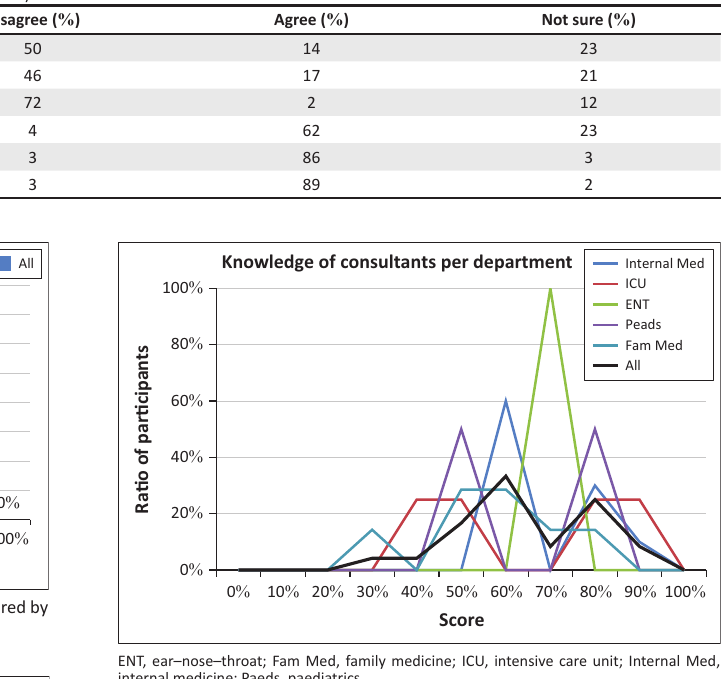
FIGURE 3: Comparison of consultants’ overall knowledge of ototoxicity across